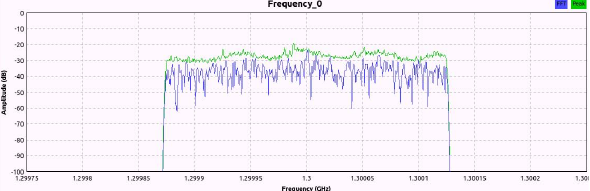
Figure 5. Secondary user receives at 1.3GHz.